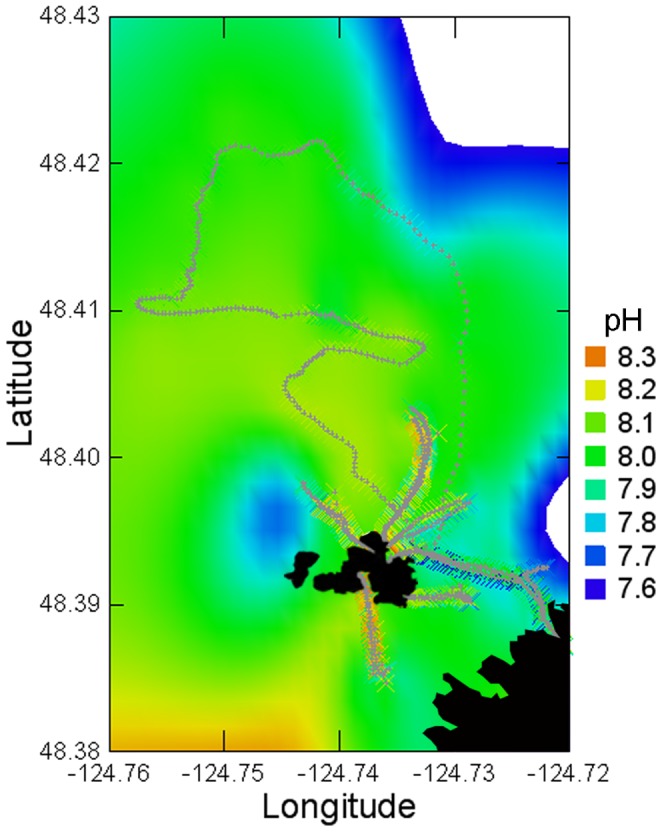
Spatial pattern of pH (NIST scale) measured at 10 sec intervals from boat transects radiating from Tatoosh Island, Washington.Color scale varies from low pH (blue colors) to high pH (red colors). Transect measurement points indicated with small gray crosses superimposed over larger X's color coded for the pH of the sample. Transects spanned depths of 2 m (within 10 m of shore) to 210 m (Juan de Fuca trench in the northwestern area of the plot). Data are presented as a smoothed surface using all transect points and applying distance-weighted least squares with SYSTAT, ignoring the presence of Tatoosh Island and Cape Flattery (black). Note that most rapid color changes occur as extrapolations outside the area of the data, and therefore are unreliable.